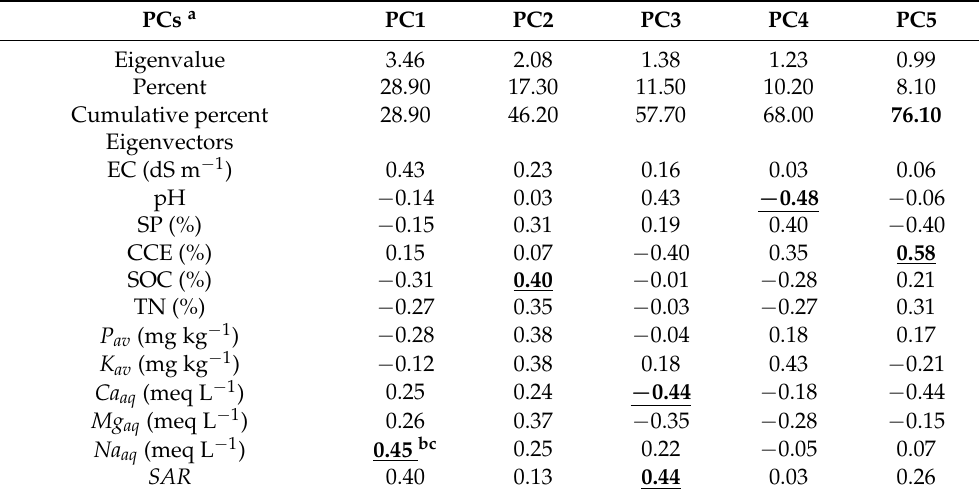
Table 5. Results of principal component analysis of eight soil properties in the studied